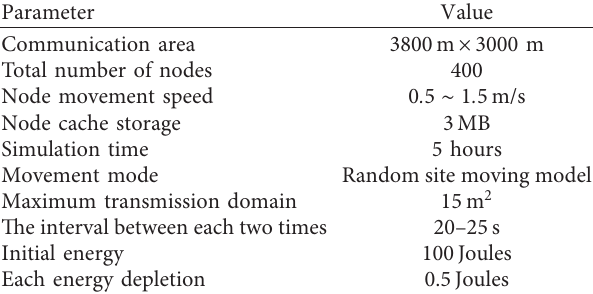
Table 1: Experimental parameter